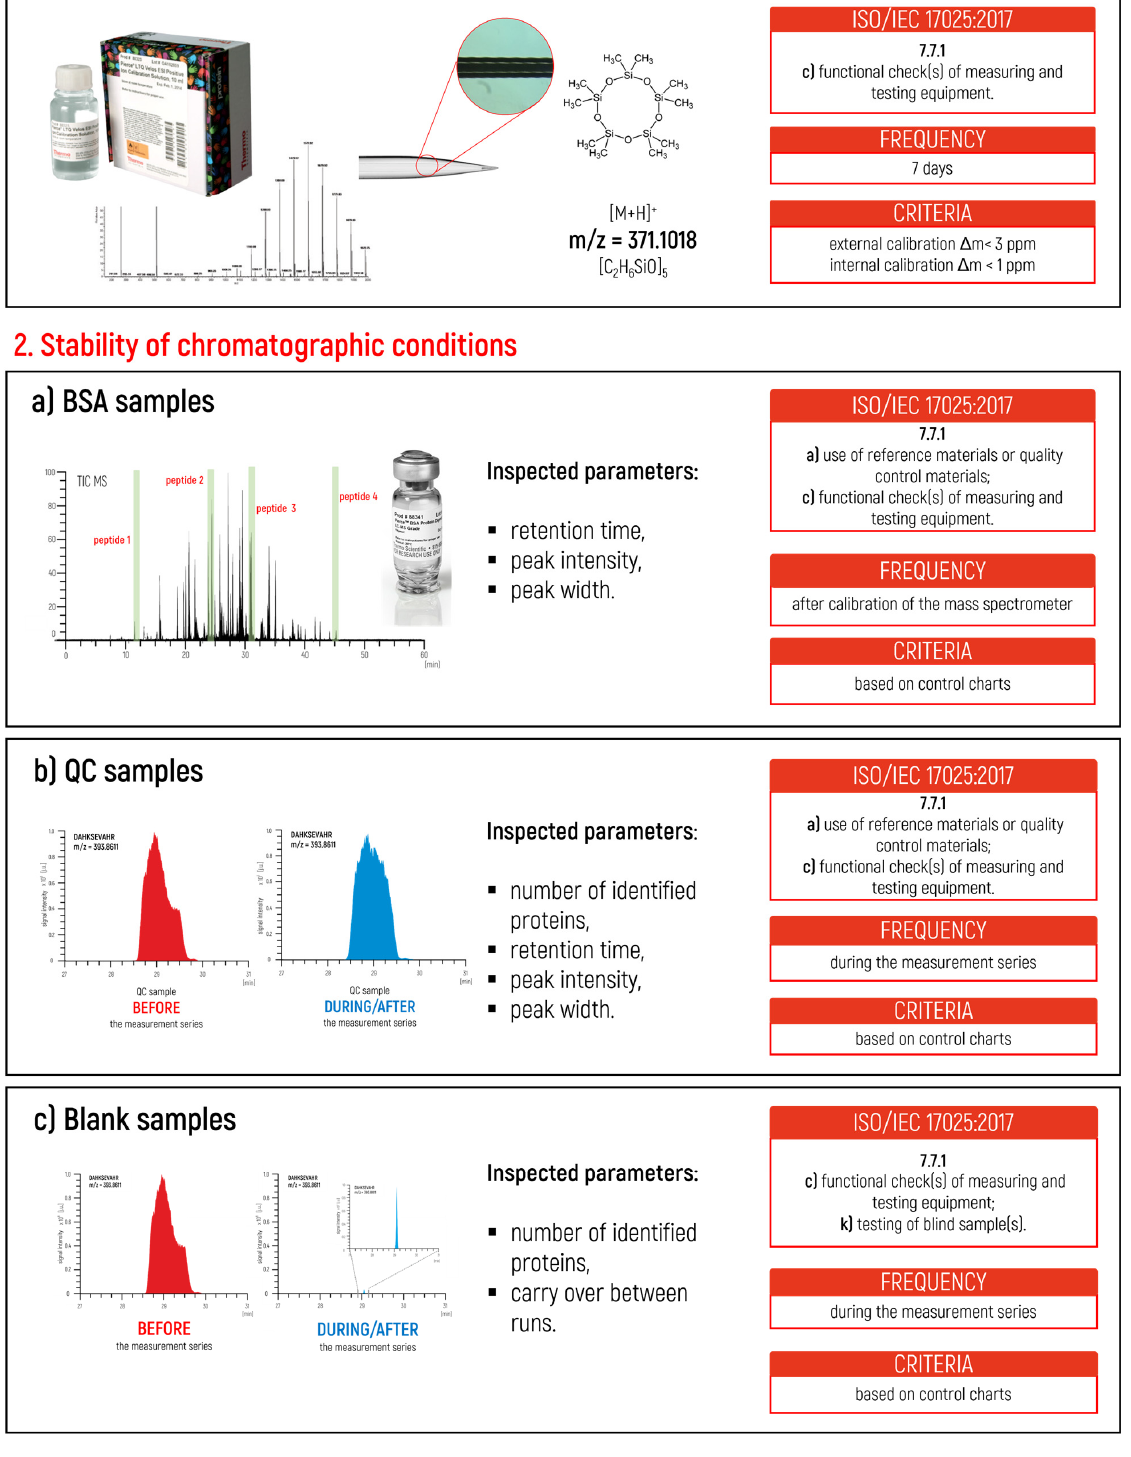
Figure 1. Main steps in ensuring the validity of proteomics results based on the ISO/IEC 17025:2017 standard.